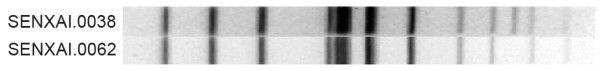
Pulsed-field gel electrophoresis of S. Enteritidis PT13 using XbaI. Two macrorestriction patterns (SENXAI) were observed, and are presented with high to low molecular weight fragments from left to right.